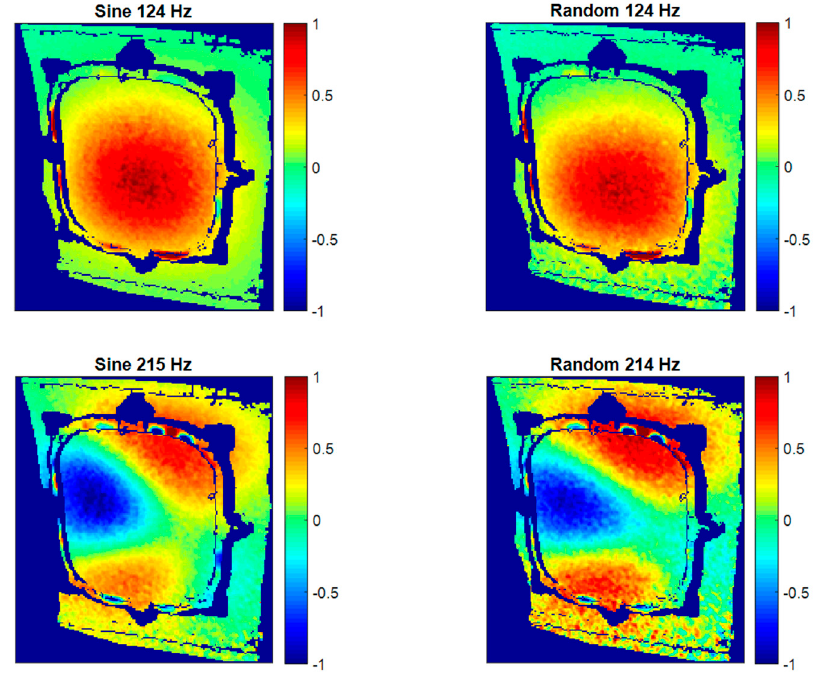
Figure 13. Normalized operational deflection shapes in the out-of-plane direction obtained using HS 3D-DIC under different excitation configurations.